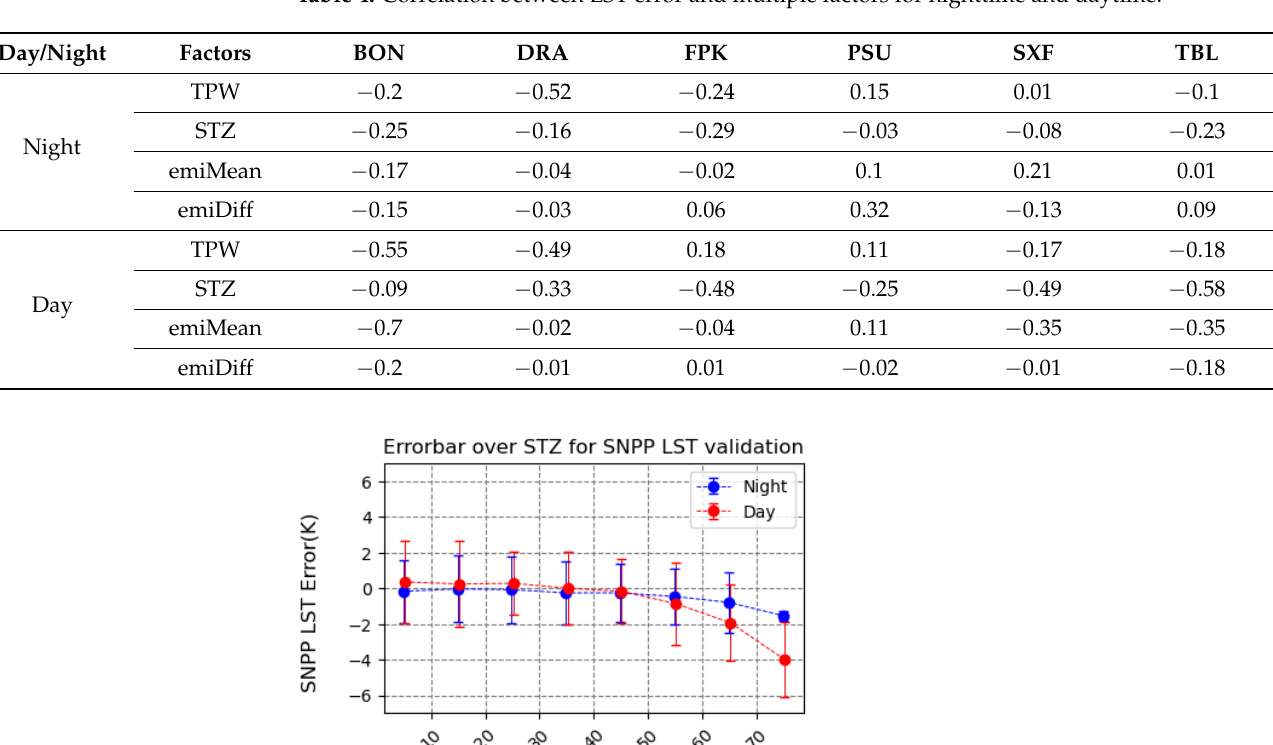
Table 4. Correlation between LST error and multiple factors for nighttime and daytime.